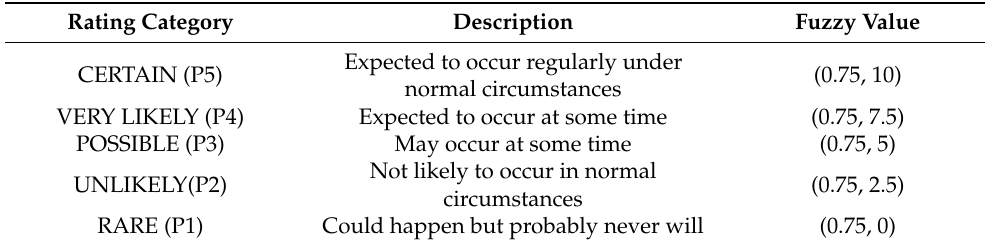
Table 5. Likelihood of scenario occurrence expressed by the frequency of its